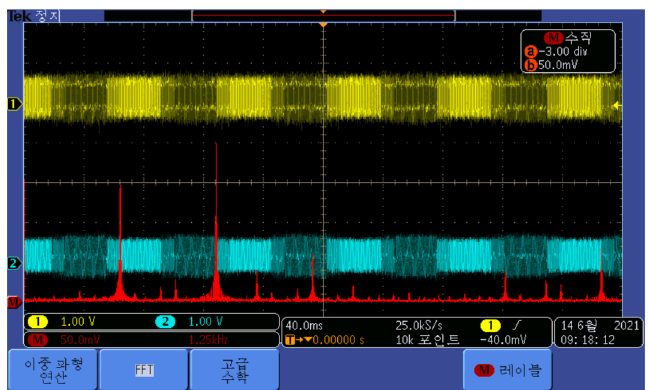
Figure 29. Transmitter and receiver frequency characteristics (high side).